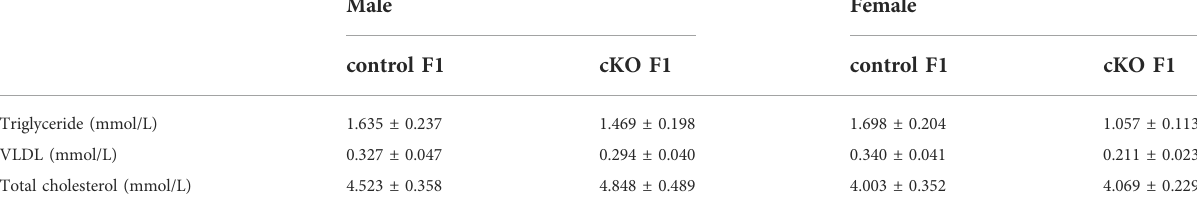
TABLE 3 The serum lipid concentrations of control and cKO F1 mice at 12-weeks of